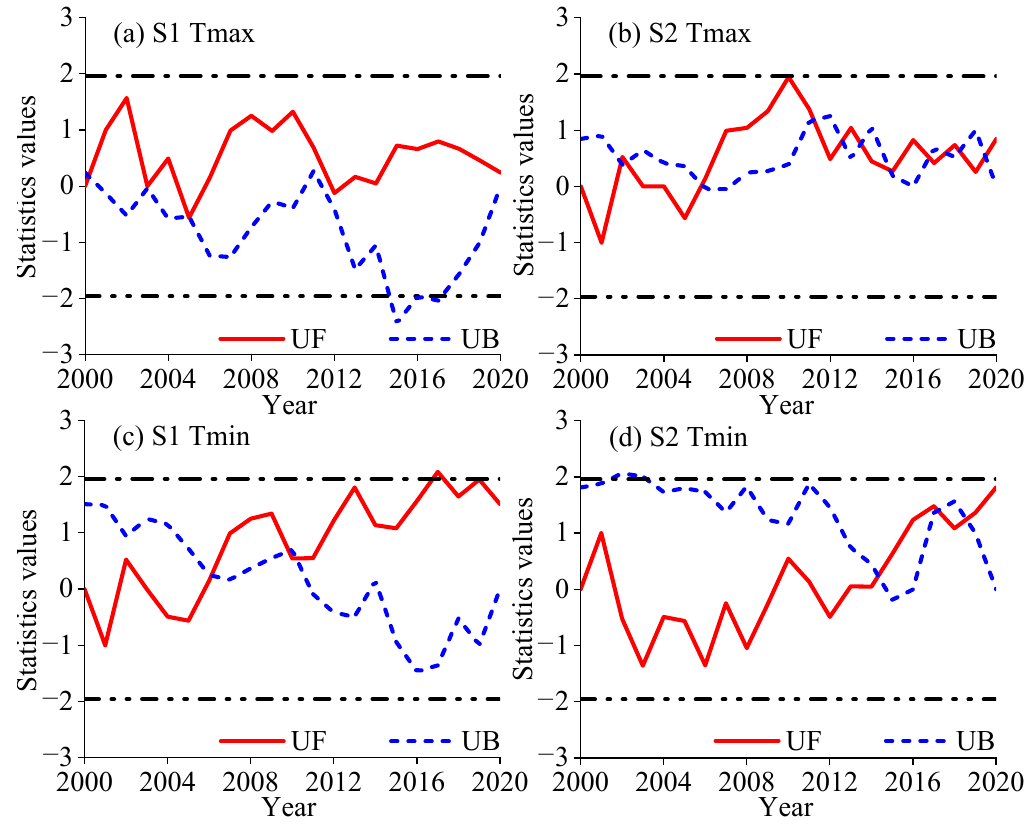
Figure 7. Mann–Kendall test for monotonic trend of ( a ) T max over S1 region, ( b ) T max over S1 region, ( c ) T min over S1 region, and ( d ) T min over S1 region. S1 and S2 represent two regions of the study area, UF and UB are statistics about temperature series, which obeys standard normal distribution. If UF and UB intersect, they represent the start time of an abrupt change.